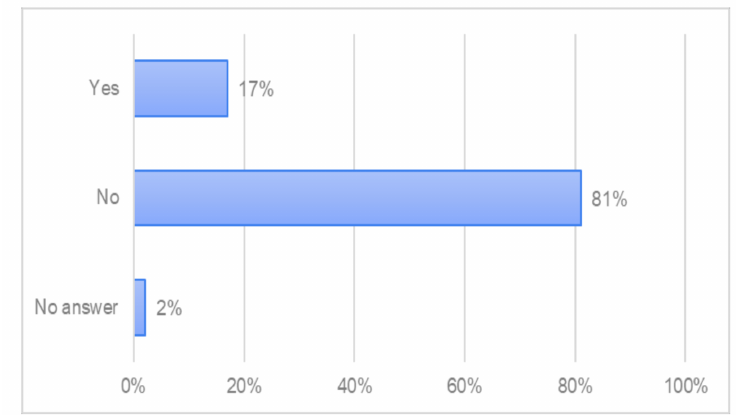
Figure 14. Injuries caused by some abiotic factors.